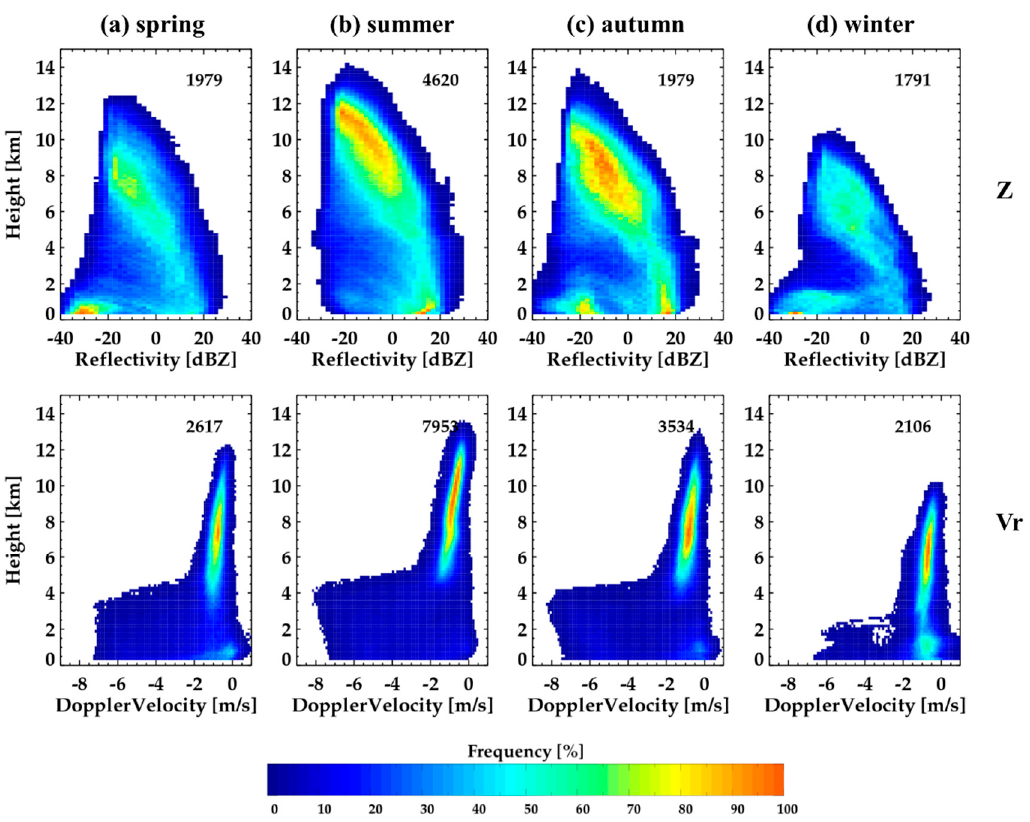
Figure 11. Contoured frequency by altitude diagrams (CFADs) of (upper) reflectivity and (lower) Doppler radial velocity for all types of clouds with seasons. ( a ) Spring, ( b ) summer, ( c ) autumn, and ( d ) winter. The number in each figure represents the maximum occurrence of clouds in the category of 2 dBZ reflectivity (0.1 m s − 1 velocity) and 150 m vertical resolution and is used to derive the percentile (color scale).